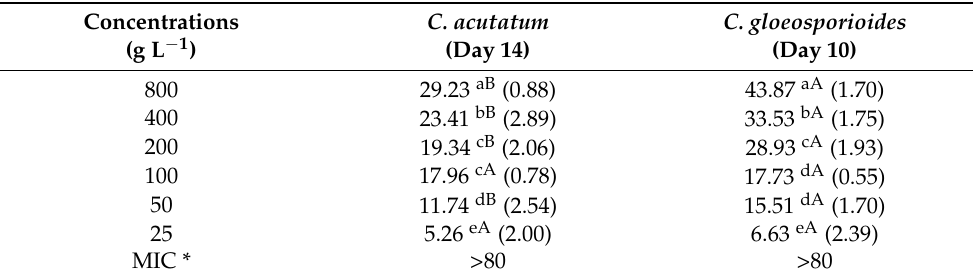
Table 1. Percentage of mycelial growth inhibition (%) of major pathogens isolated from mango exposed to various concentrations of propyl disulfide in vapor phase compared to control stored at ambient temperature (26 ± 3 ◦ C).